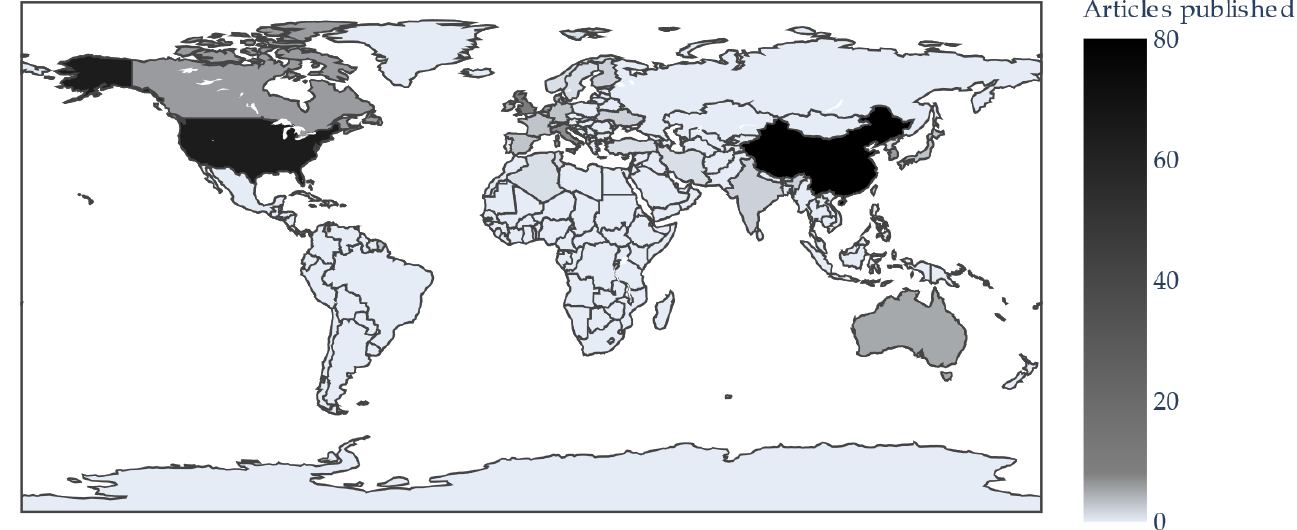
Figure 5. Authorship countries represented in the reviewed articles.